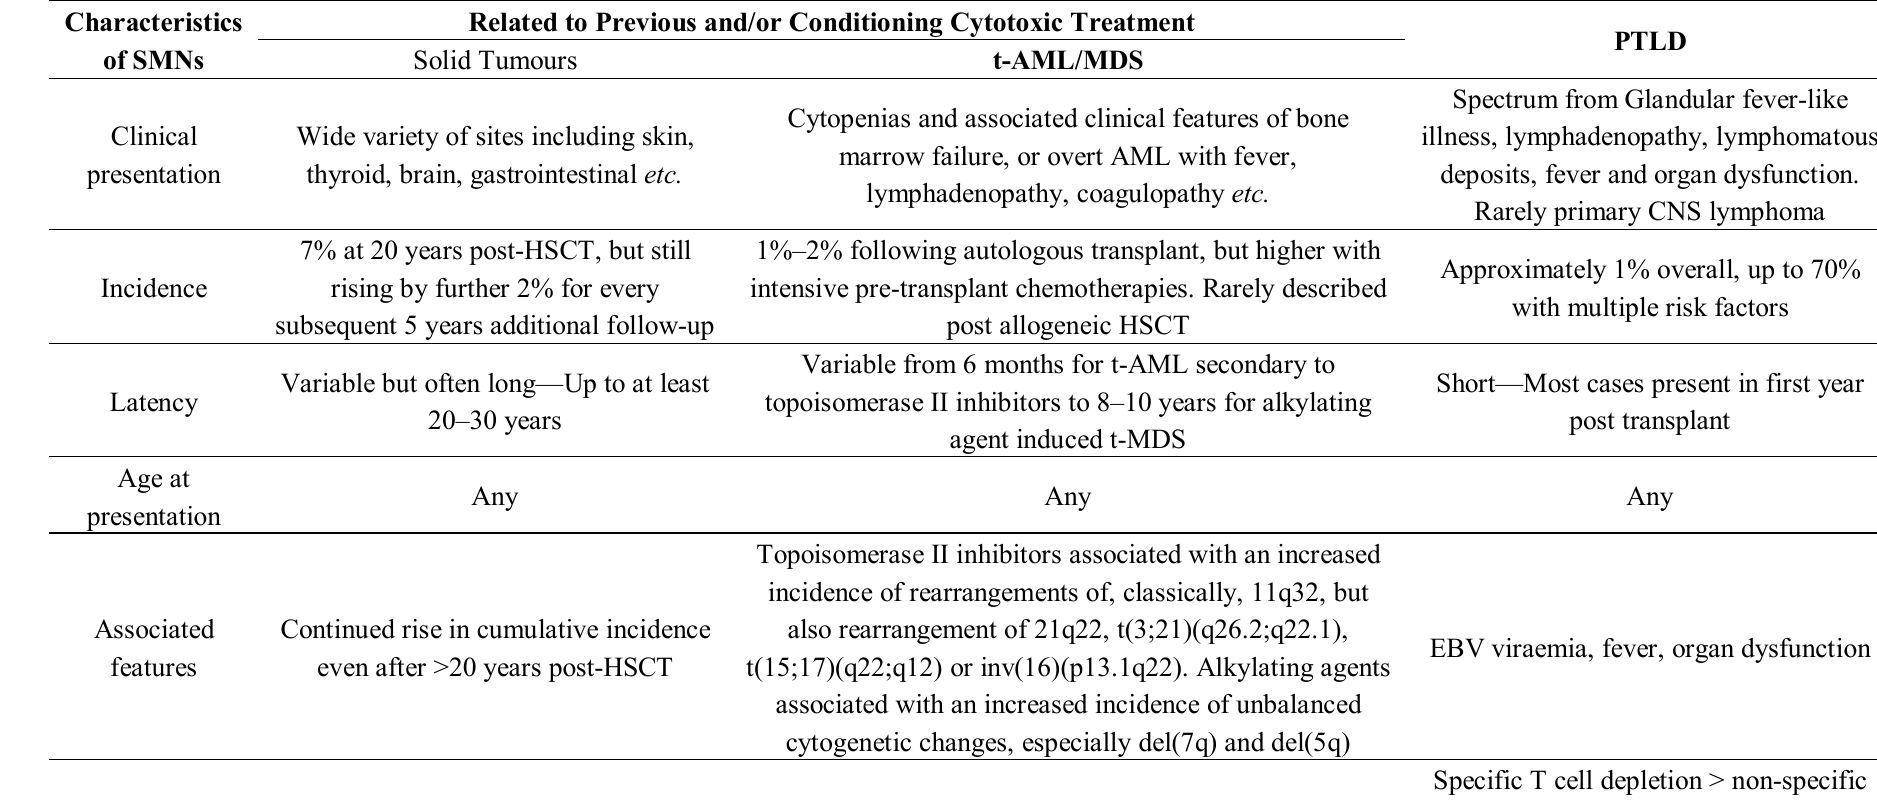
Table 1. Features of secondary malignancies following HSCT performed in childhood [13]. Please confirm the